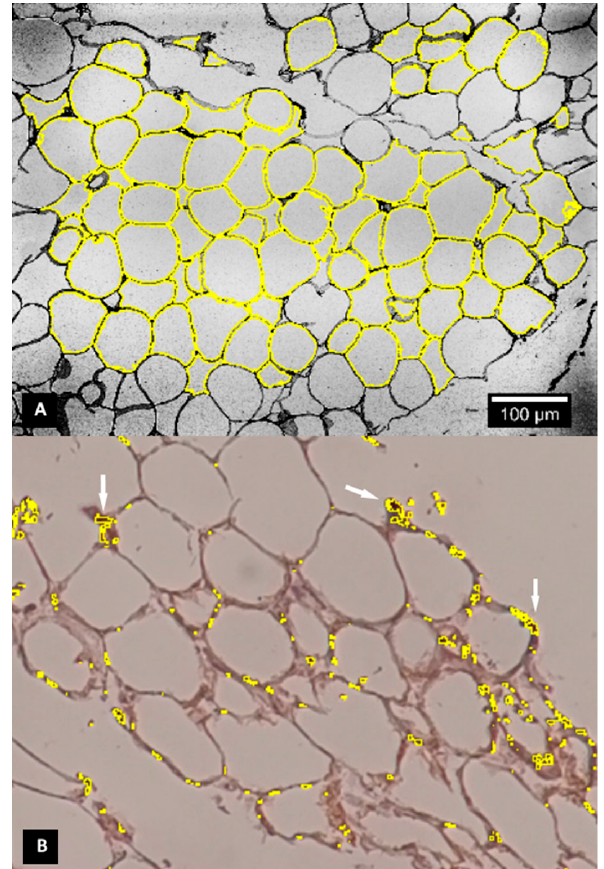
Figure 1. Representation of vacuole size measurement and SREBP-1 and UCP-1 expression determination using ImageJ. ( A ) The vacuole size measurement. Images were first transformed in 8-bit black and white, then color inversion and particle analysis were performed (circularity 0–1, size 100–10,000 µ m 2 ). The vacuoles are outlined with yellow. ( B ) Quantification of positive reaction from section of adipose tissue. First, the total area of adipose tissue in section was measured, then the areas corresponding to the positive reaction were selected (having RGB code R: 40–120, G: 20–60, B: 20–60—outlined with yellow) and measured. Larger spots of positive reaction are shown with arrows.